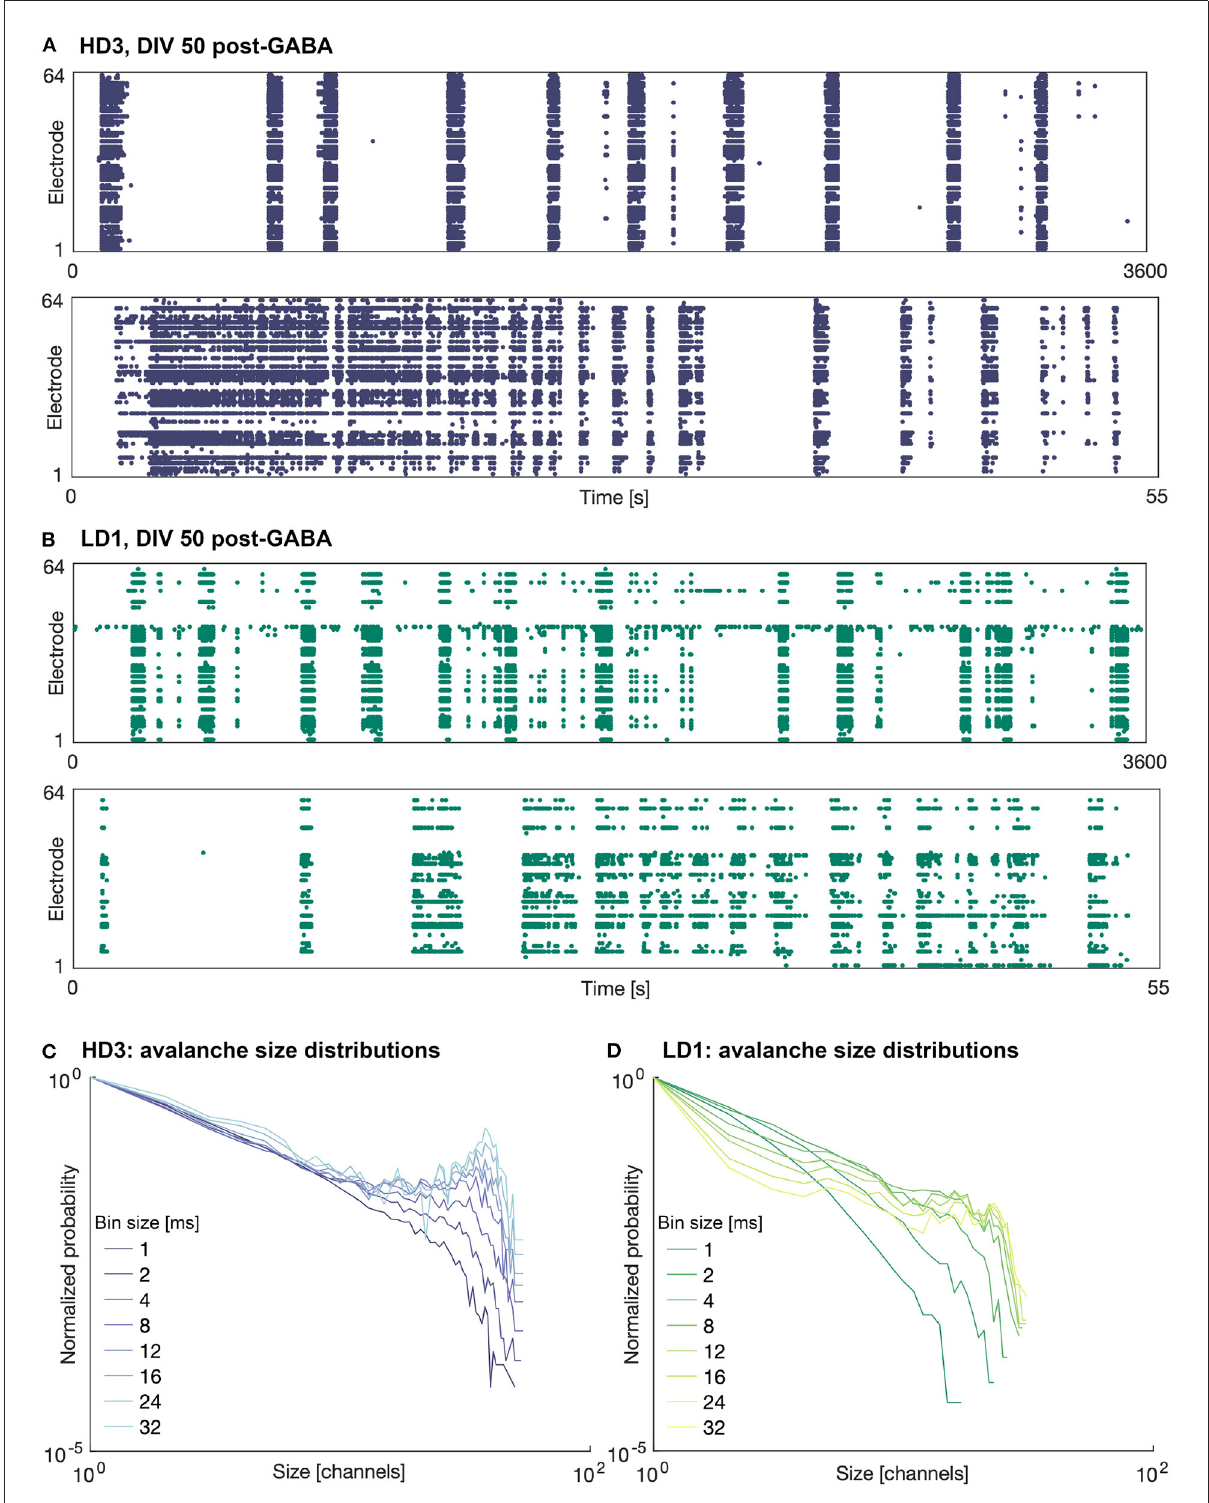
FIGURE4 Raster plots and avalanche size distributions on DIV 50 following perturbation by GABA. Raster plots of the entire 1 h recording period (upper) and indicated 55 s period (lower) for (A) HD3 and (B) LD1. Avalanche size distributions obtained with different time bin widths normalized by the probability of size 1 for (C) HD3 and (D)